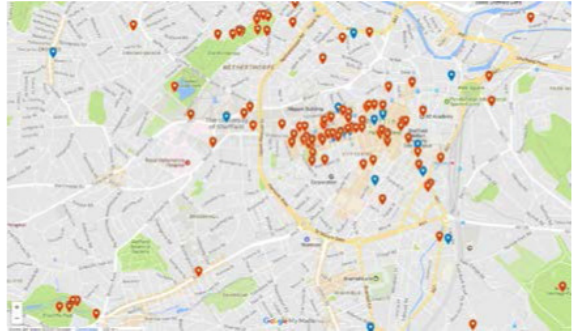
Figure 4. Map visualizing geolocated tweets using the Tramlines festival